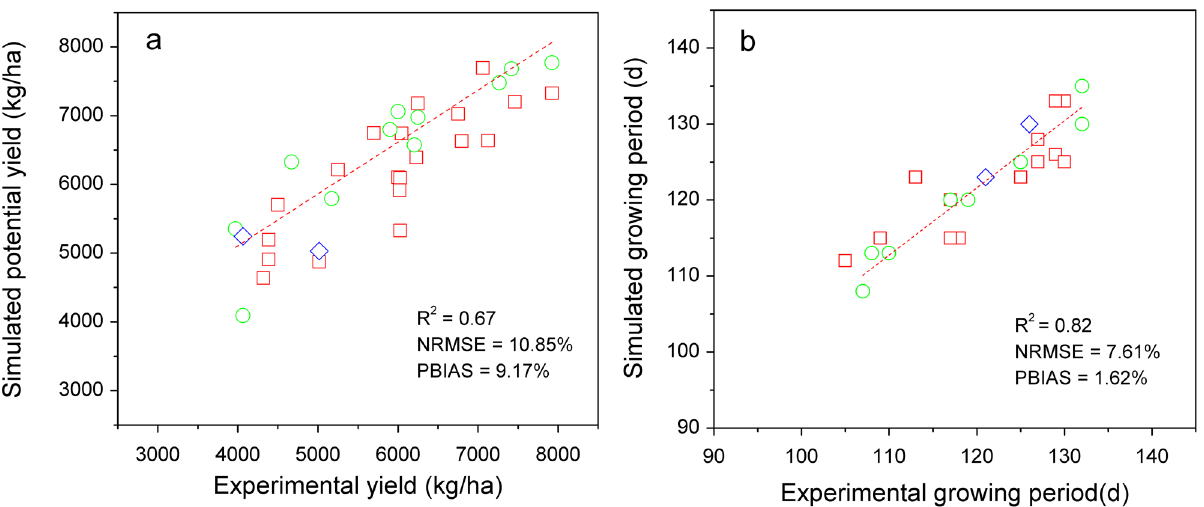
Figure 2. Comparison of simulated potential yield ( a ) and growing duration ( b ) of highland barley with observed data. Square, circle and diamond indicate the simulated and experimental results of Chaiqing-1, Zangqing-2000 and Diqing-1